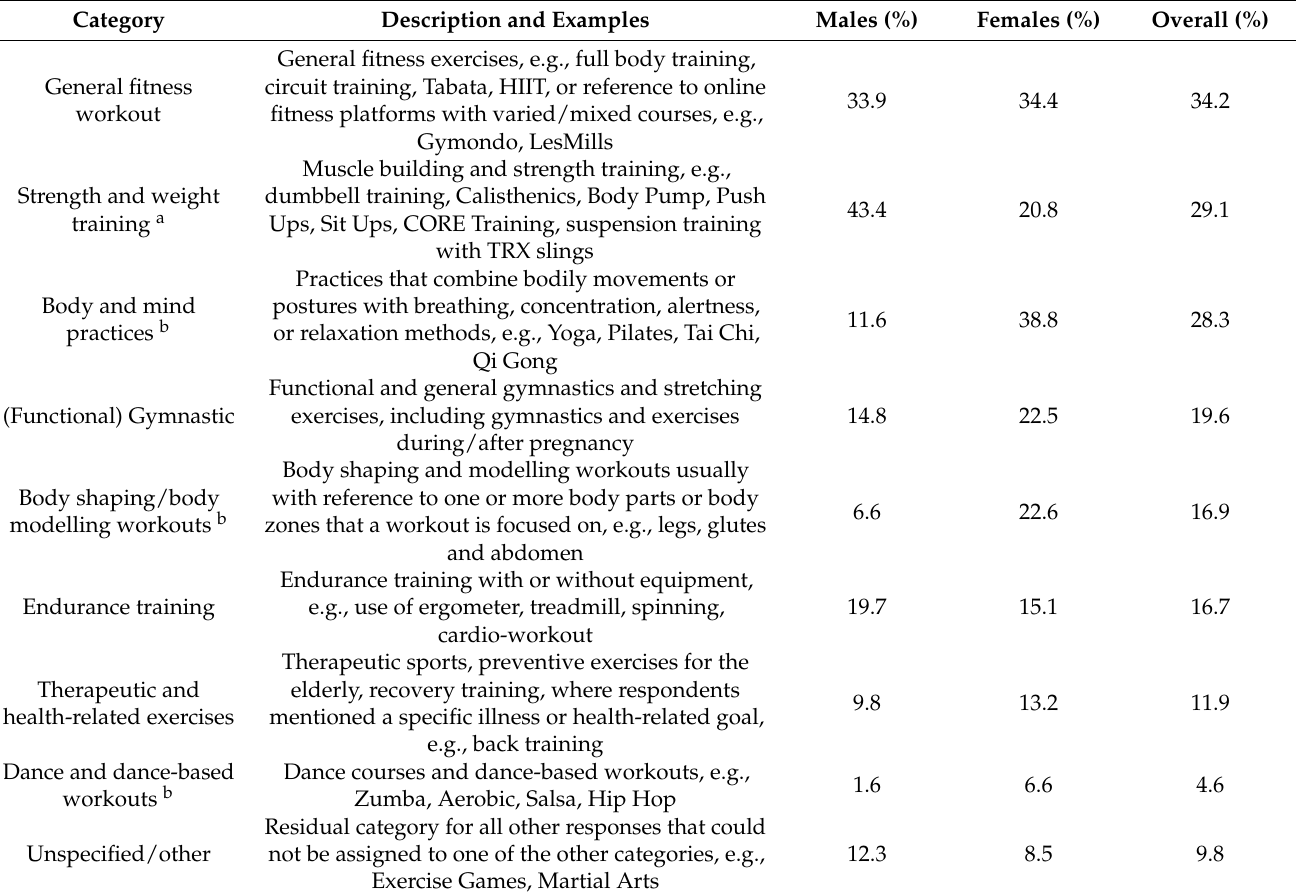
Table 1. Categories of most popular digital sports